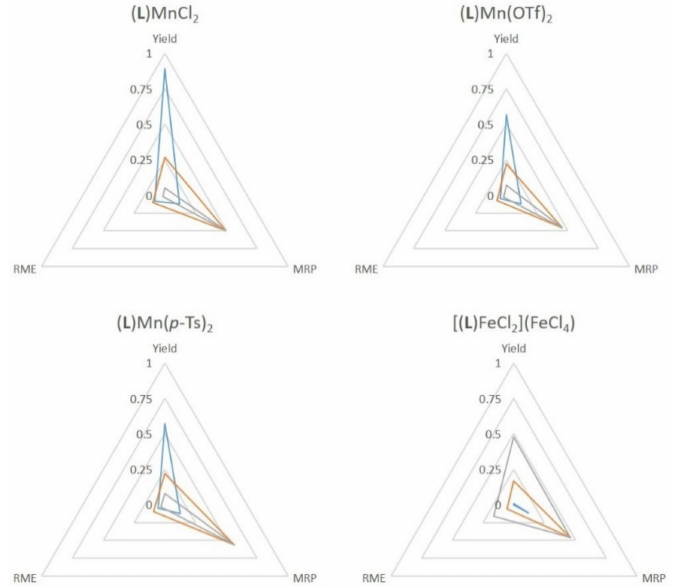
Figure 20. Comparison of green metrics for the epoxidation of cyclohexene (the yield considered the cyclohexene oxide only) (yield, RME and MRP) with the different catalysts and the different